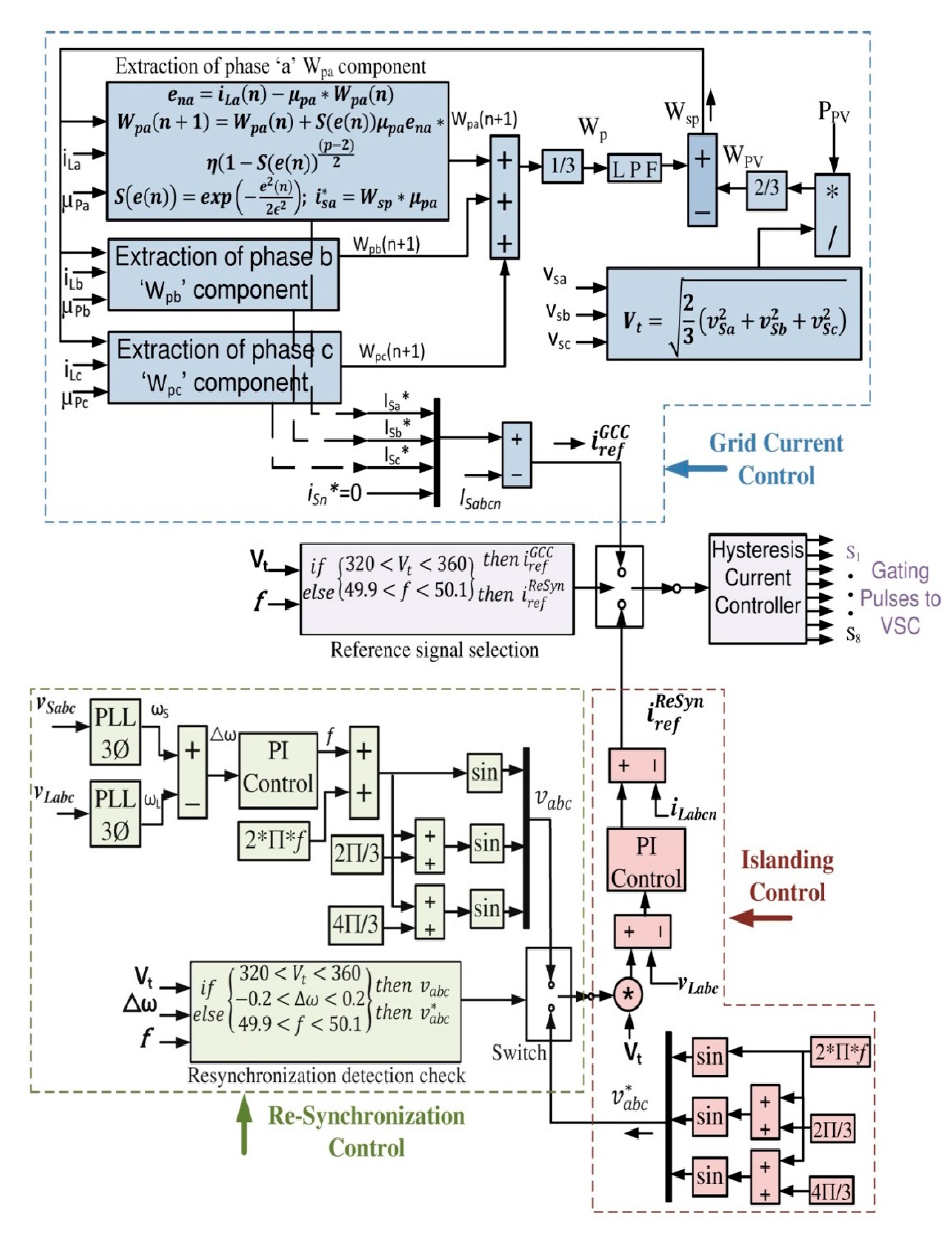
Figure 3. VSC Control.